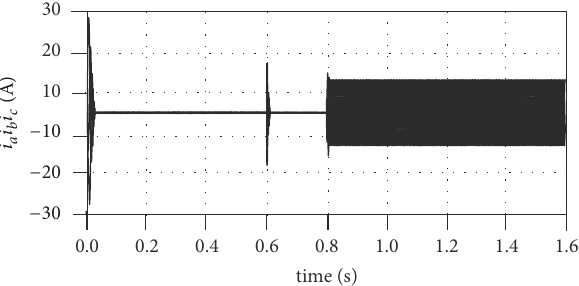
Figure 2: Rotation speed responses.